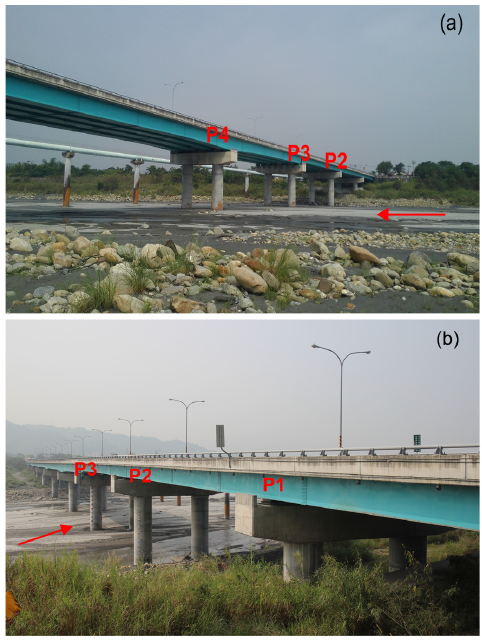
Figure 4. The near field of Mingchu Bridge ( a ) looking downstream; ( b ) looking upstream, photos taken in May 2014.